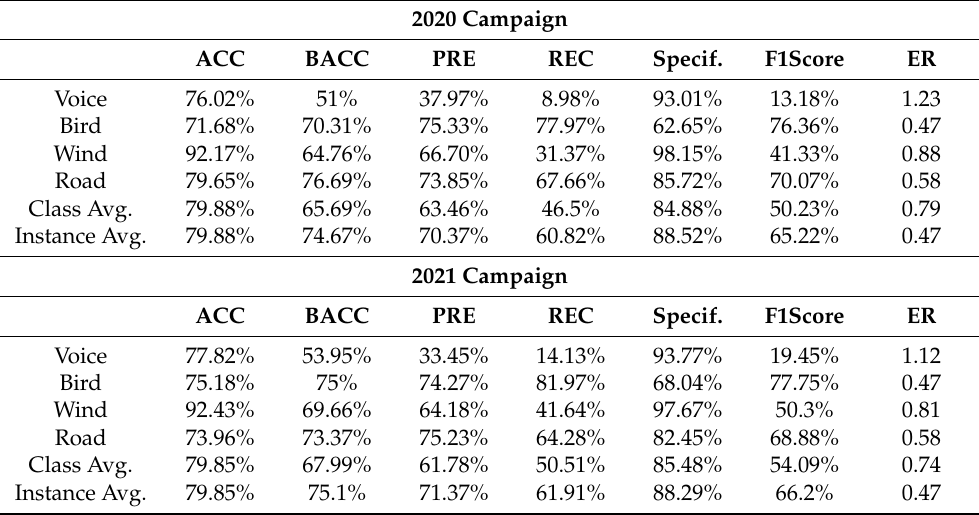
Table 5. Summary of Metrics assessing the classification performance for the four most prevalent sounds during the 2020 and 2021